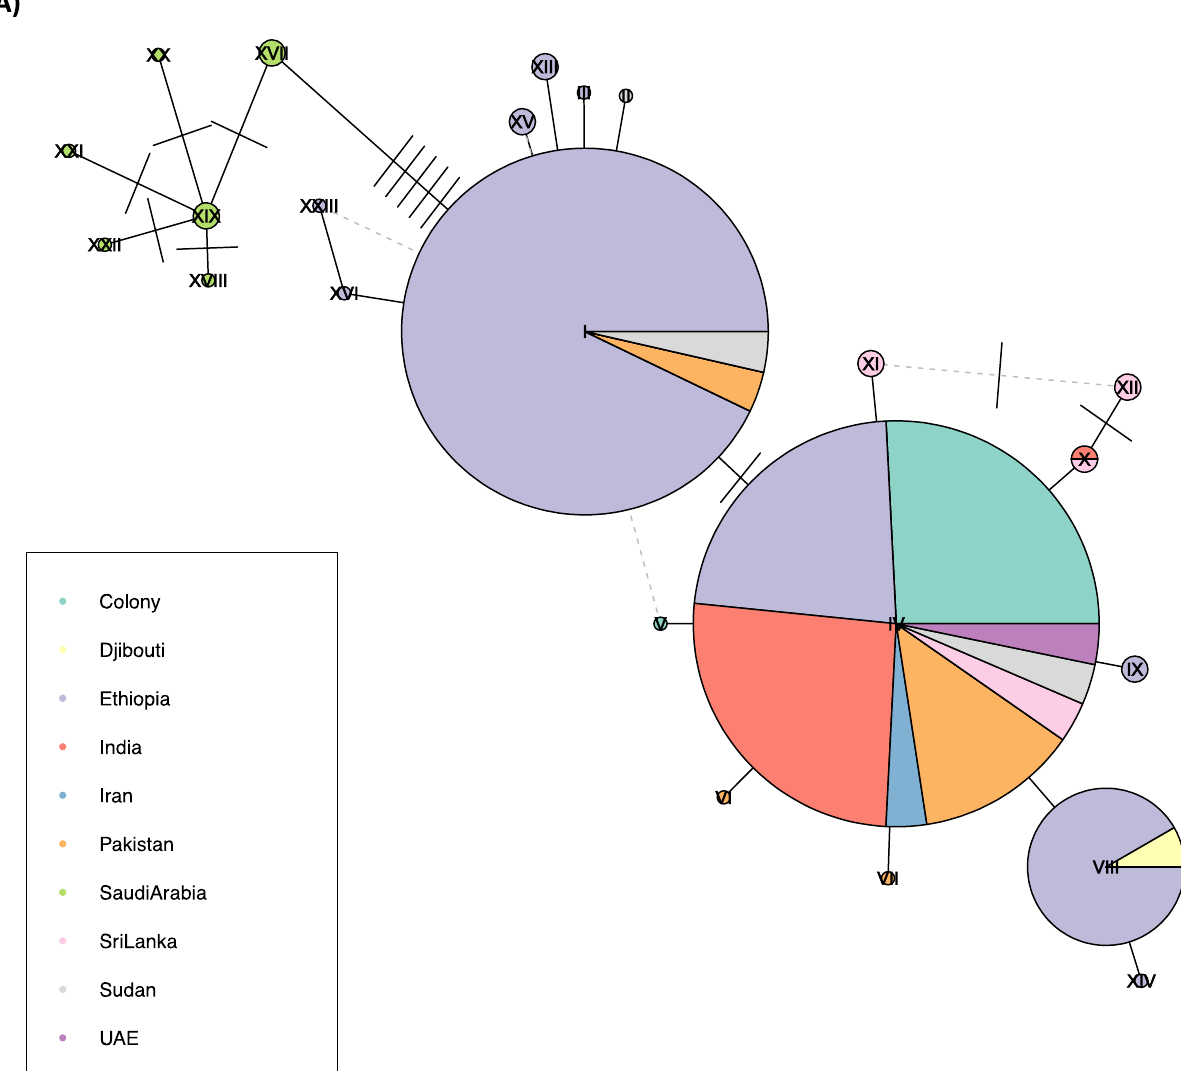
Figure 3. Haplotype or minimal-spanning network constructed using cox-1 sequences (A) and its2 sequences (B) generated in this study alongside publicly available data. Each node represents a haplotype, with each segment in the node representing a country, proportionally sized to the number of samples present in the segment and node. The number of nucleotides differences between haplotypes is represented by the number of ticks between